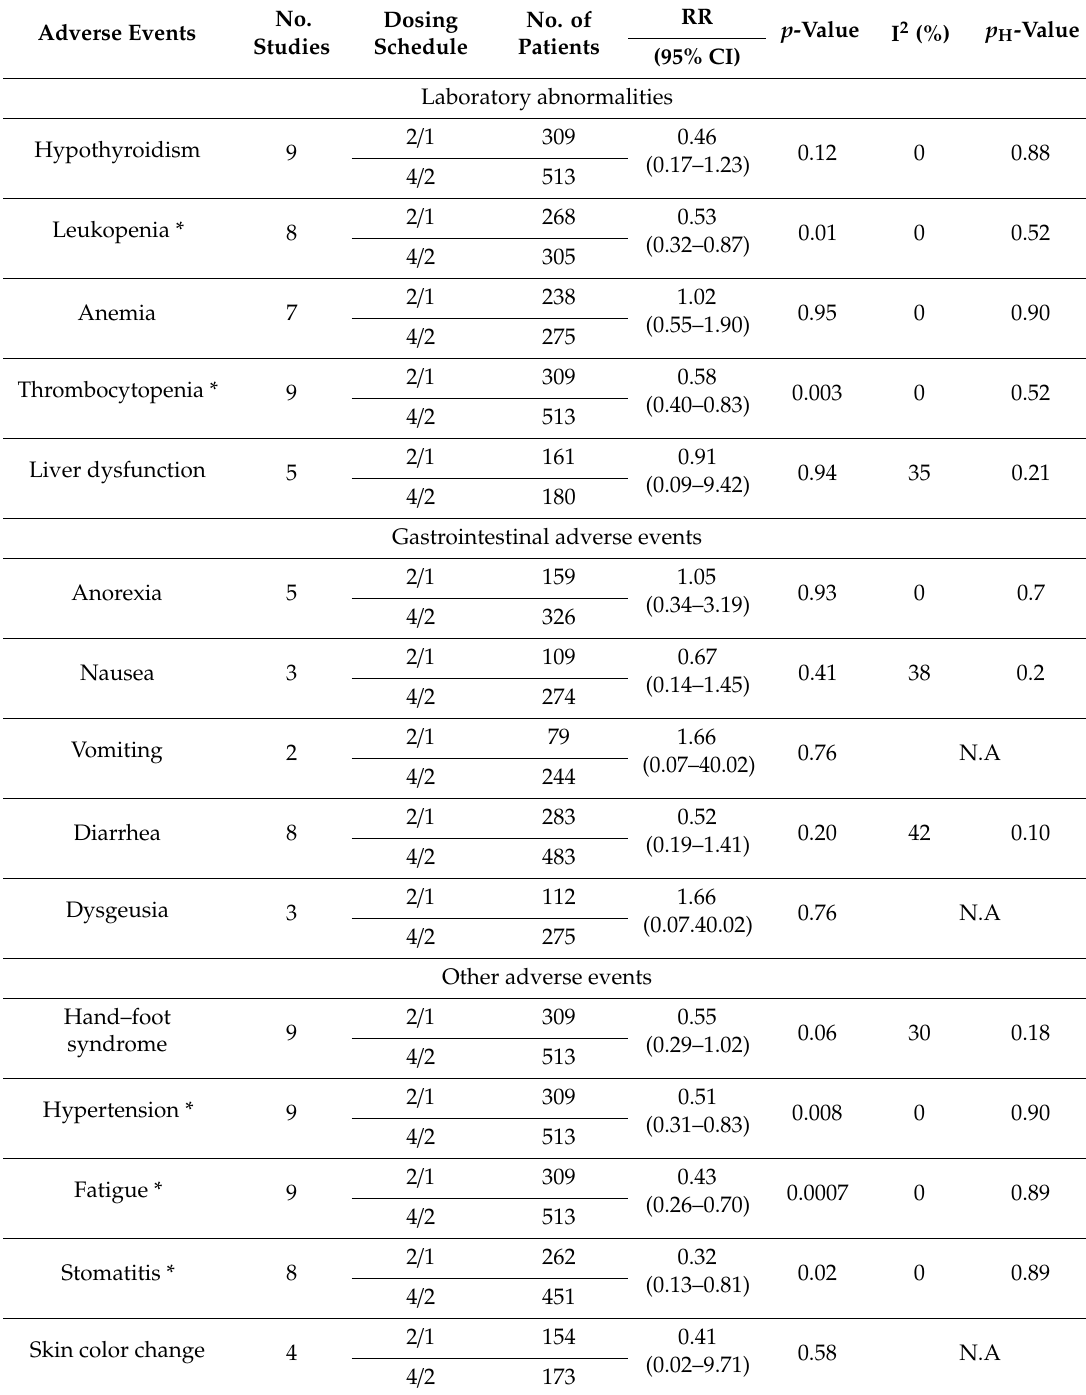
Table 6. Meta-analysis of high-grade adverse events according to dosing